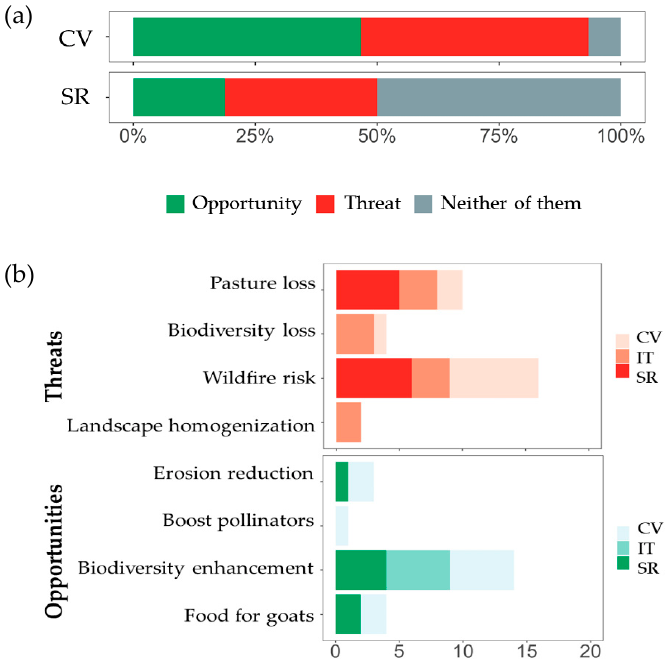
Figure 5. Stakeholder views on shrub expansion in the study areas ( a ) perceived as threat, opportunity or neither of them, shown as the percentage of responses over the total number of people interviewed within each study area, and ( b ) consequences of shrub expansion identified as threat or opportunity by interviewees represented by the number of citations. CV: interviewees from Colmenar Viejo and Tres Cantos; SR: interviewees from municipalities of Sierra del Rincón; IT: Interterritorial